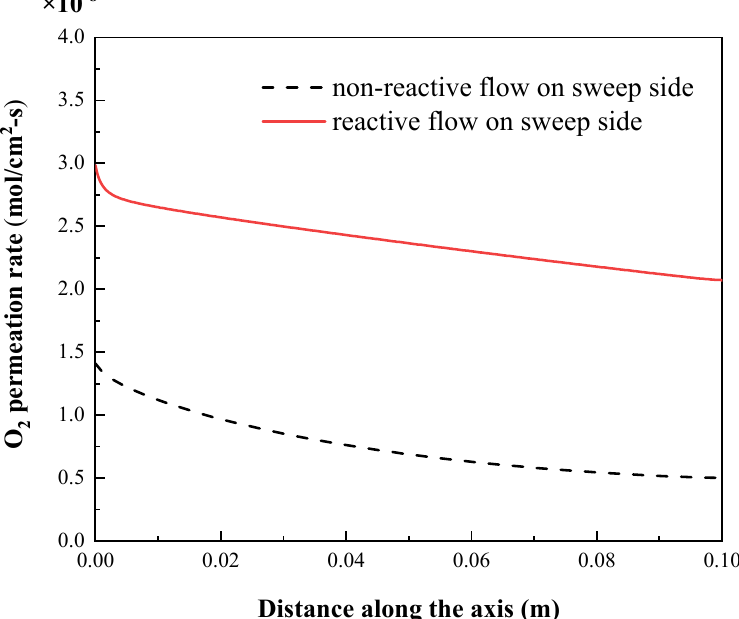
Figure 8. Distribution of O 2 permeation rate under non − reactive and reactive flow on sweep side.